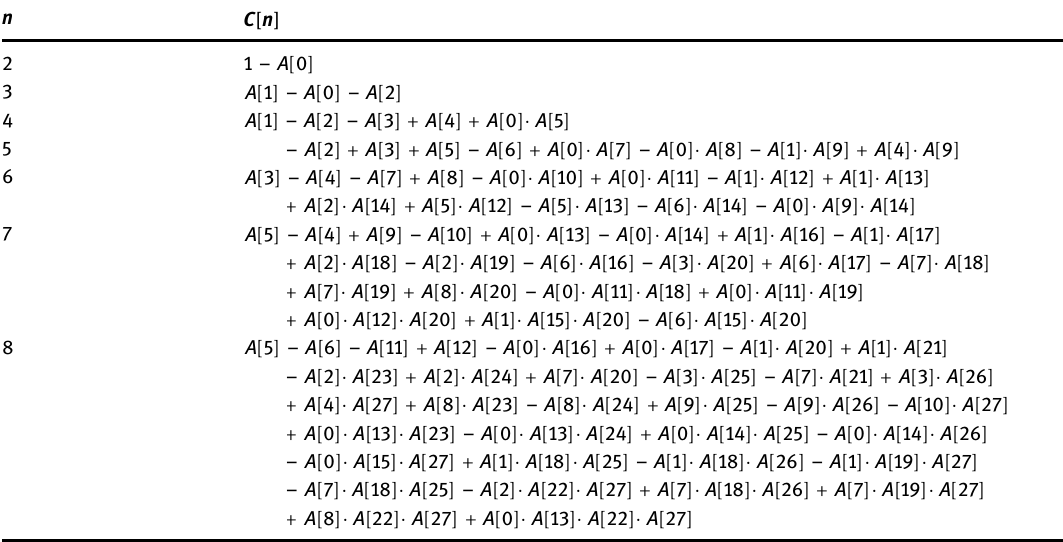
Table 5: The determinantal expressions [ ] C n , for ⩽ ⩽ n 2 8 , used in Algorithm